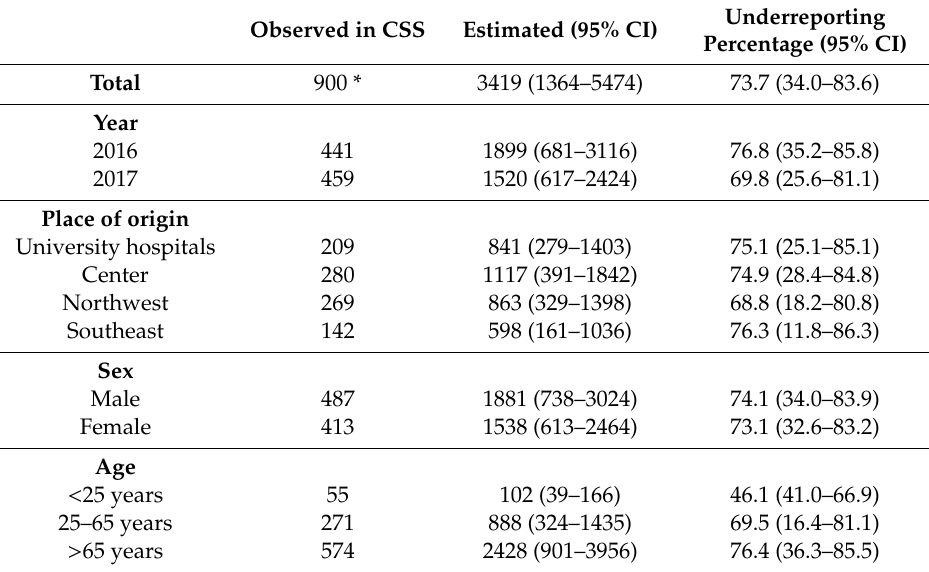
Table 2. Estimated number of unreported cases of invasive pneumococcal disease in the CSS according to a log-linear capture–recapture model. CI, confidence